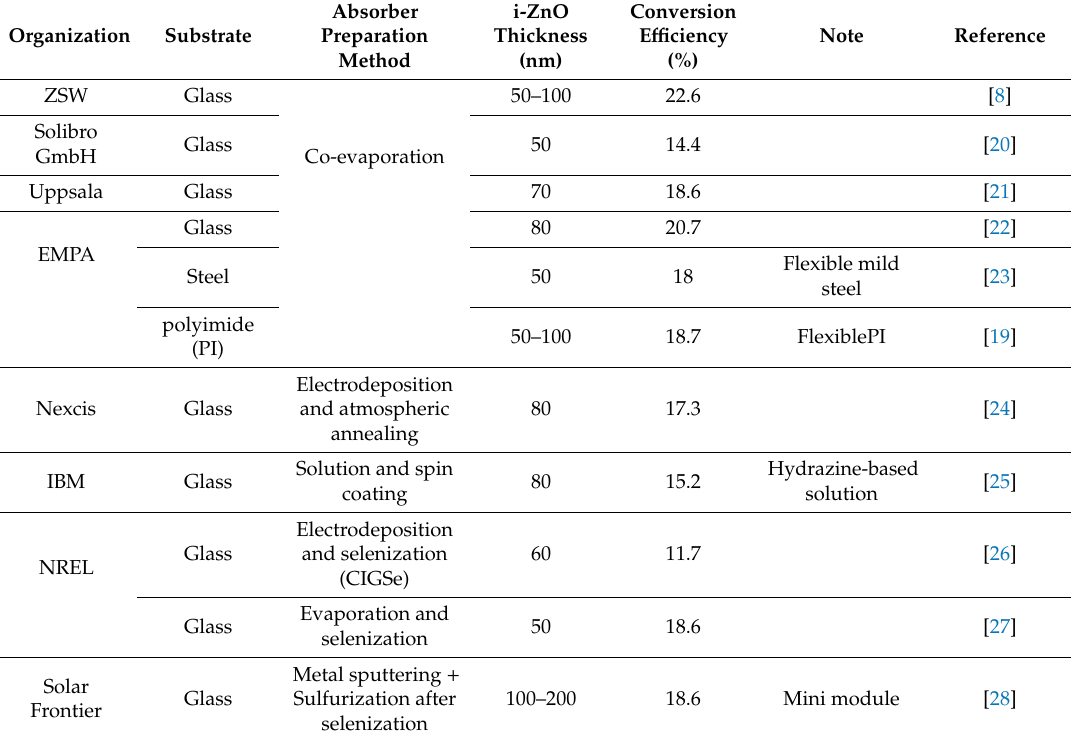
Table 1. Summary of the i-ZnO thickness for di ff erent CIGS processes by several research groups and